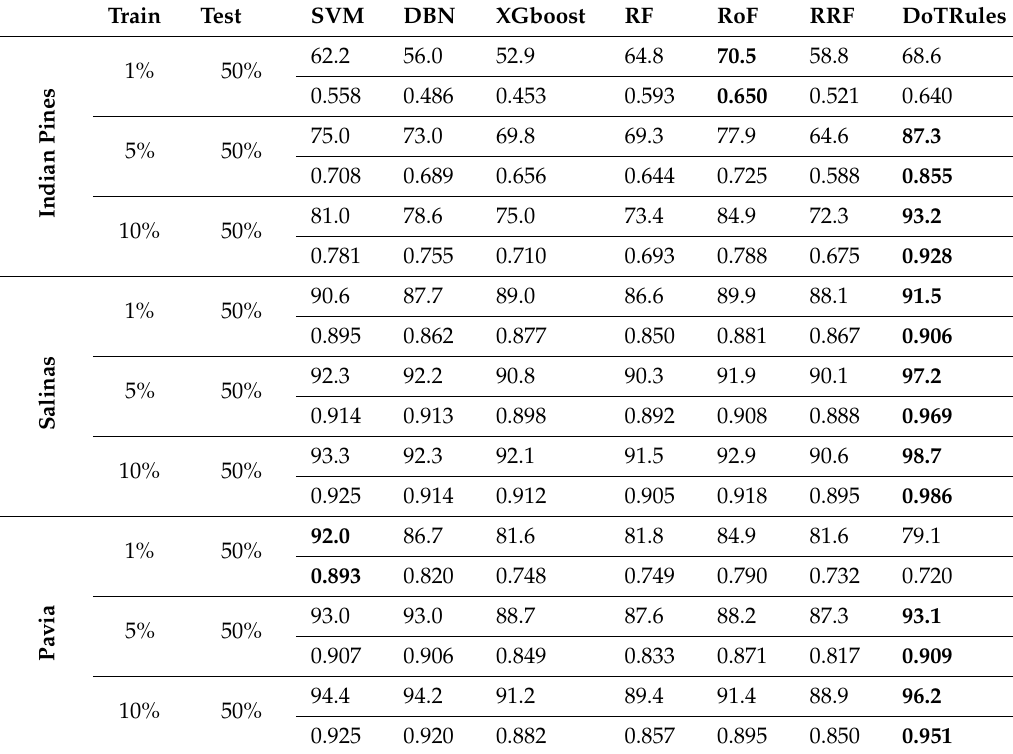
Table 1. The accuracy assessment results of three applied datasets, including the overall accuracy (OA%) and kappa coe ffi cient ( κ ) for all applied methods including support vector machine (SVM), deep belief network (DBN), extreme gradient boosting (XGBoost), random forest (RF), rotation forests (RoFs), regularised random forest (RRF), as well as Dictionary of Trusted Rules (DoTRules). The maximum values are highlighted in